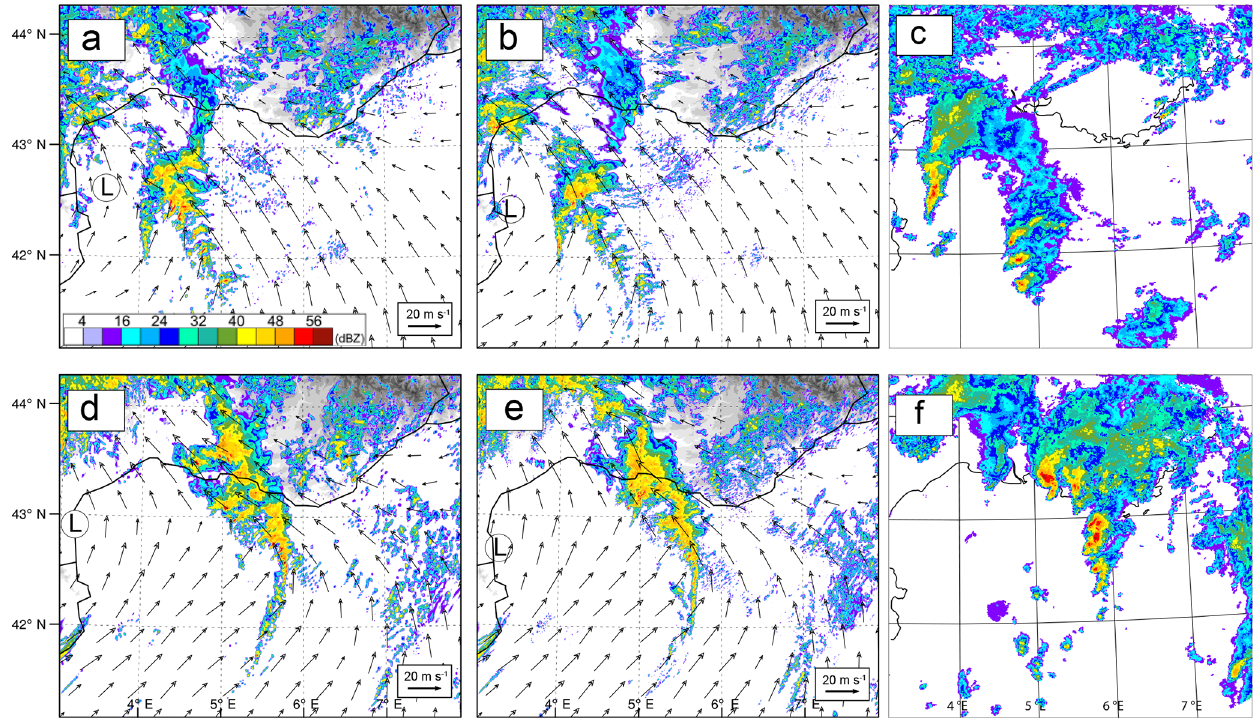
Figure 6. Simulated radar reflectivities (dBZ) at 850hPa and horizontal winds (ms − 1 ) at 950hPa from (a) LR450 and (b) LR150 at 09:00UTC on 26 October 2012, respectively. Panels (d) and (e) are the same except for 12:00UTC. The symbol L marks the location of the surface low-pressure system. Panels (c) and (f) represent the observed radar reflectivities at 09:00 and 12:00UTC,